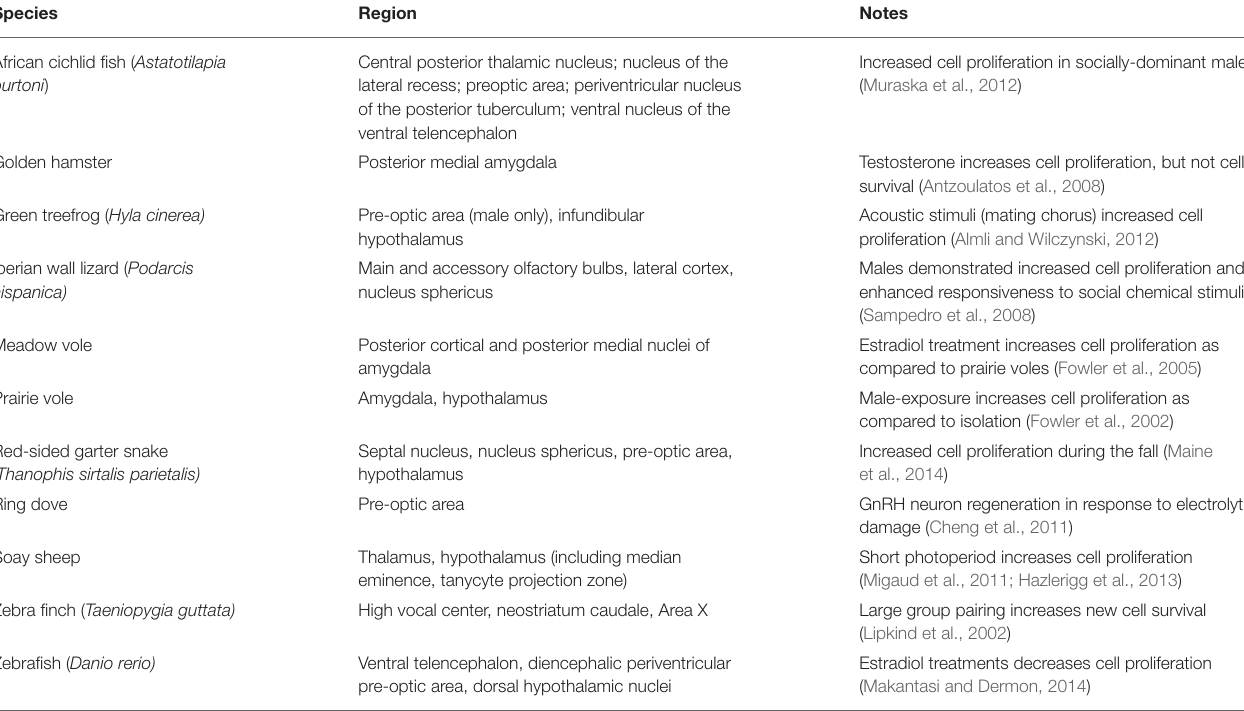
TABLE 1 | Evidence for adult neurogenesis in non-neurogenic niches in non-traditional animals likely attributed to sociosexual adaptations.